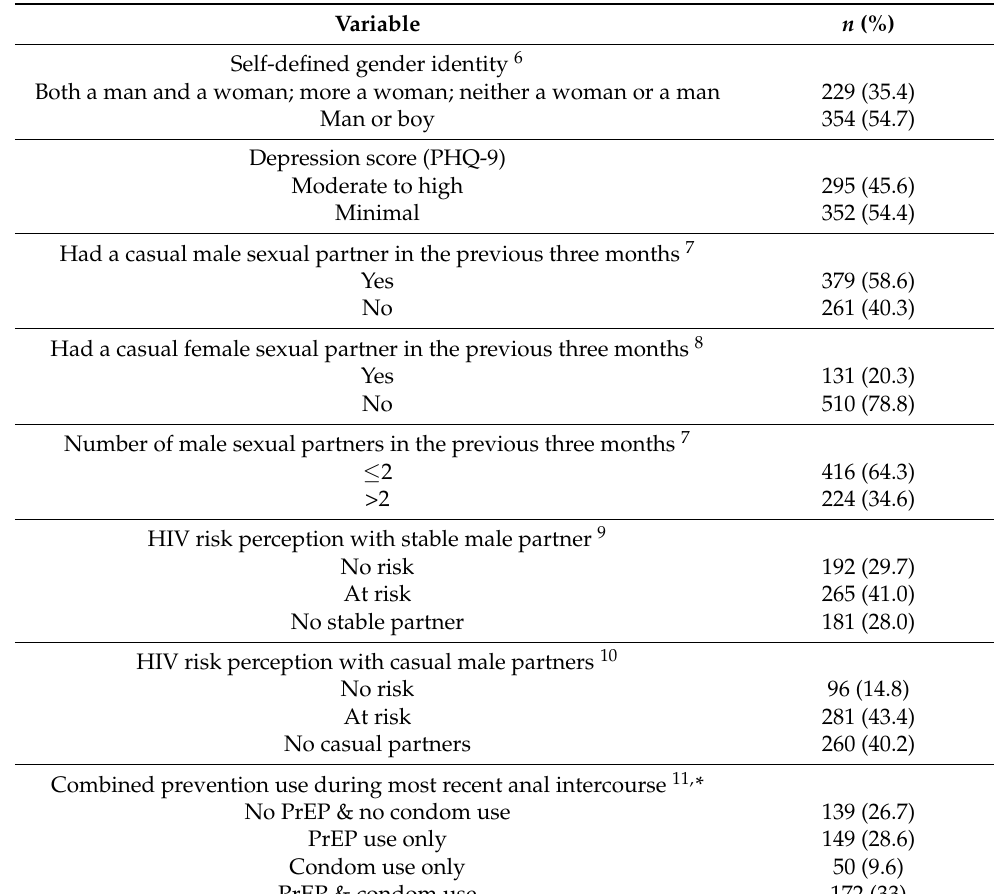
Table 1. Cont. Variable n (%) Self-defined gender identity